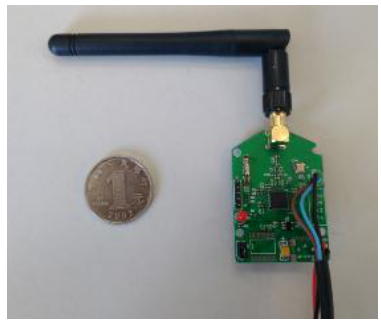
Figure 3. Wireless sensing node.